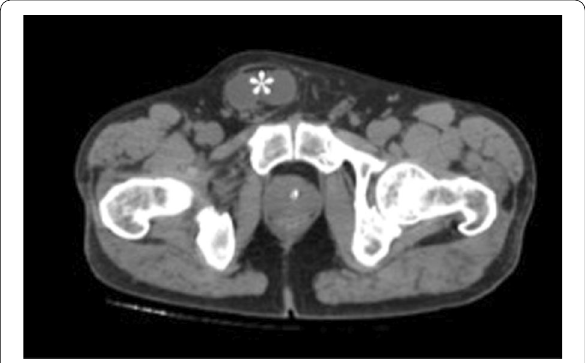
Fig. 2 Axial section of the CTU, showing herniation of the ureter through the right inguinal canal. * Right inguinal canal